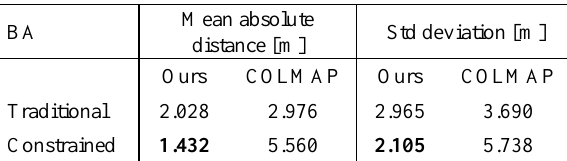
Top view of the region outlined in Side view of the region outlined in green Top view green rectangles rectangles Figure 4 . Visual results for dense reconstruction of two cameras with overlap. First row: reconstruction results of using COLMAP without rig_bundle_adjuster . Second row: reconstruction results of using COLMAP with rig_bundle_adjuster . Third row: reconstruction results of using our SfM pipeline with traditional BA. Fourth row: reconstruction results of using our SfM pipeline using the proposed baseline constraint. The green rectangles outline the regions with large drift (row 1-3) and the improvement (row 4). The purple and blue rectangles outline both ends of the drifted trajectory, where we could observe the poses of corresponding camera pairs were not correctly estimated. The orange rectangle (row 4) outlines the same region where our proposed baseline constraint improved the accuracy of the estimated camera poses, while COLMAP’s rig_bundle_adjuster could not solve the drift problem. We could observe the impact of the baseline constraint (row 4) in correcting the drift in the estimated trajectory and